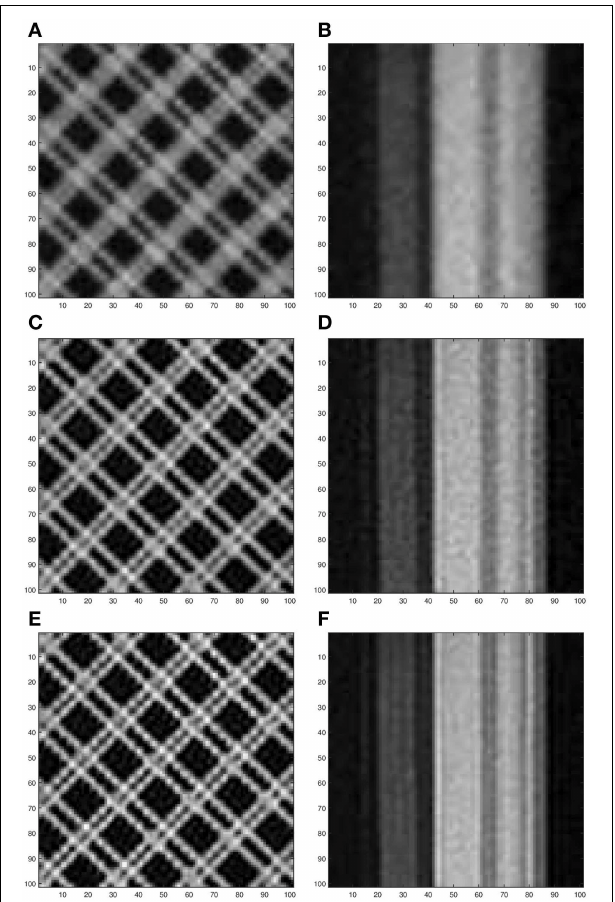
FIGURE 18 | Two processed ROIs from the real image sequence (data set II). Bicubic output for ROI 1 (A) and ROI 2 (B) . AWF SR output for ROI 1 (C) and ROI 2 (D) . CAWF SR output for ROI 1 (E) and ROI 2 (F)